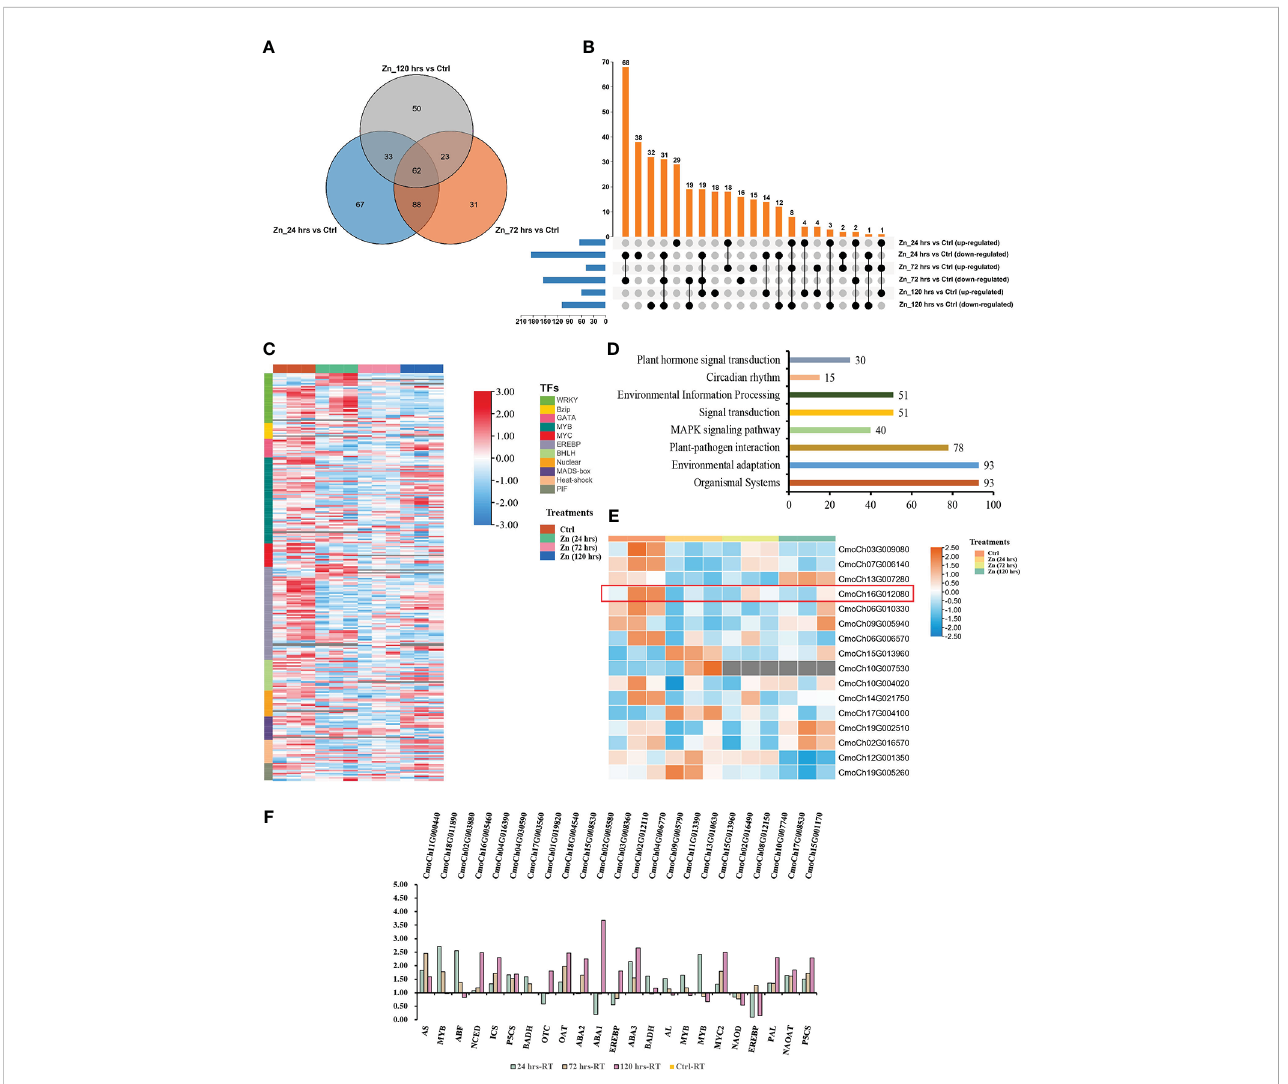
FIGURE 6 Regulated TFs in pumpkin by Zn (A – D) . (A) Venn diagram indicating the overlaps between the differentially expressed TFs in the pumpkin at 24 hrs, 72 hrs, and 120 hrs after Zn treatment, respectively. (B) UpSet visualisation of the number of up-regulated or down-regulated TFs in the pumpkin at three different conditions compared to the control. Filled circles and vertical lines represent the corresponding TFs (either up-regulated or down-regulated) being compared. The left bar graph for the UpSet plot shows the number of signi fi cantly increased or decreased TFs in each of the six comparisons upon Zn treatment. (C) Heatmap generated using the TFs with changed abundance. Red and blue colours separately indicate the relative high or low abundance in four experimental conditions. The column and row banners represent the classi fi cations of different treatments and component classes, respectively. (D) Regulated TFs classi fi ed into plant hormone signal transduction and MAPK signalling pathway. (E) Heatmap generated with the regulated MYC2 TFs. Orange and blue colours separately indicate the relatively high or low abundance in four experimental conditions. The column banner represents classi fi cations of different treatments. (F) The expression analysis of differentially expressed genes using qRT-PCR. The x and y axises separately represent gene names and fold changes of regulated